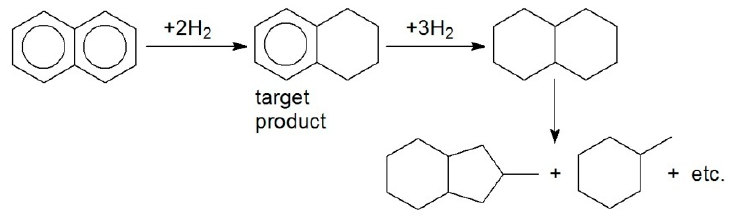
Figure 4. Simplified scheme of selective hydrogenation of NL to TL.